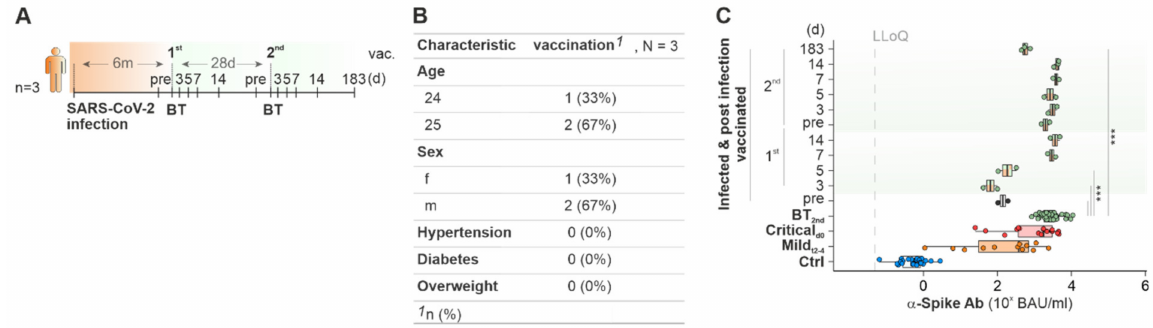
Figure 5. Ab titers against Wuhan SARS-CoV-2 Spike protein after infection and subsequent vaccina- tion over time. ( A ) Vaccination scheme, ( B ) table of clinical characteristics and ( C ) Concentrations of α -Spike-Ab of patients after infection and subsequent vaccination at indicated timepoints. LLoQ, Lower Level of Quantification; Mann–Whitney U test; unadjusted p -value ( C ); *** p Val <